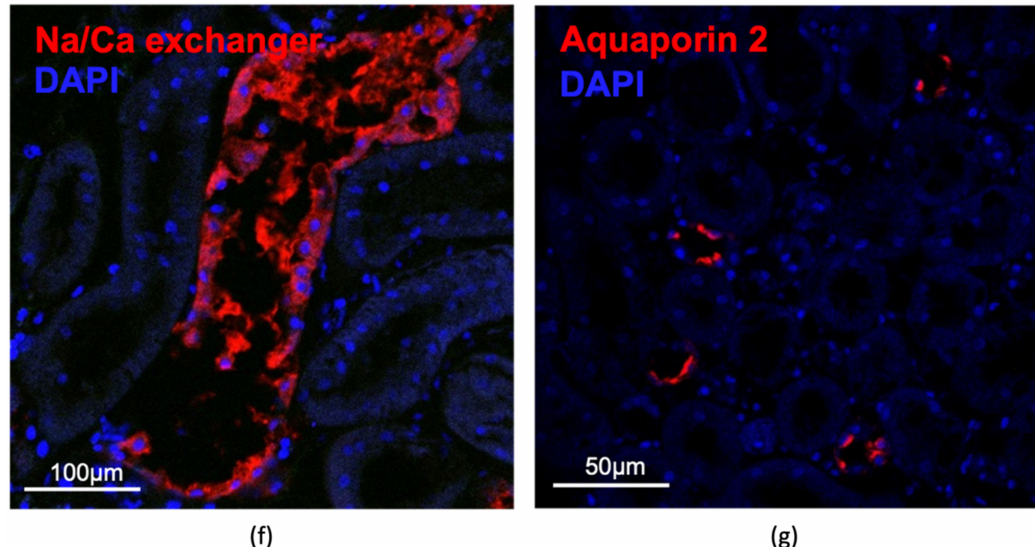
Figure 5. Histological and immunofluorescence analyses of kidney slices after removal from the CAM; ( a ) H&E staining; ( b ) proximal tubules and podocytes stained with megalin (red) and podocin (green), respectively; ( c ) only single apoptotic-activated caspase 3-positive cells could be detected; ( d ) detection of CD31 in renal vessels; ( e ) uromodulin- and ( f ) Na/Ca exchanger-positive cells showed damage, while ( g ) aquaporin 2-positive cells were preserved. Nuclei were stained with DAPI (blue).